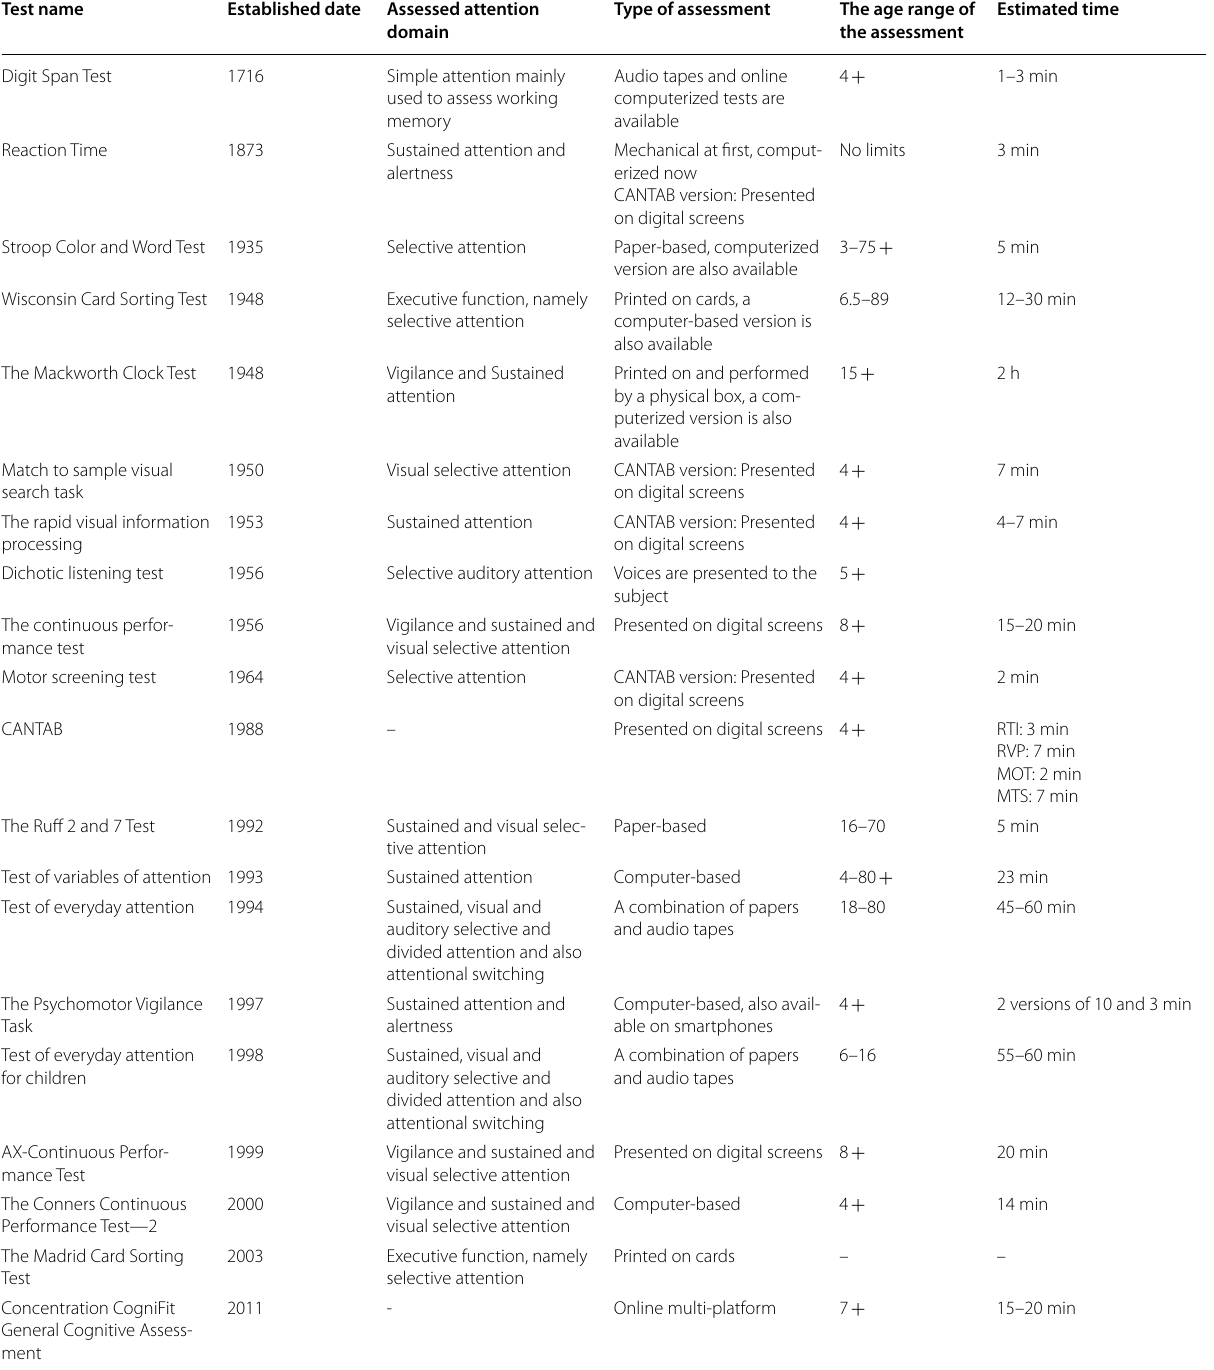
Table 1 Summary of available attention